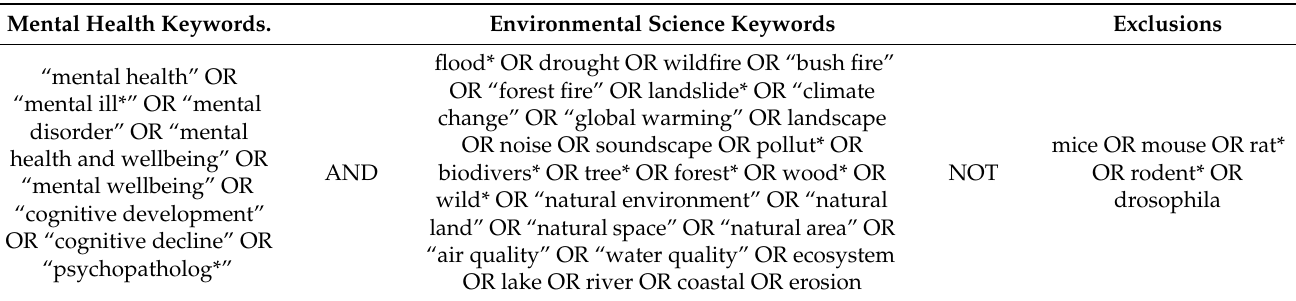
Table 1. Search strings used in the Web of Science and